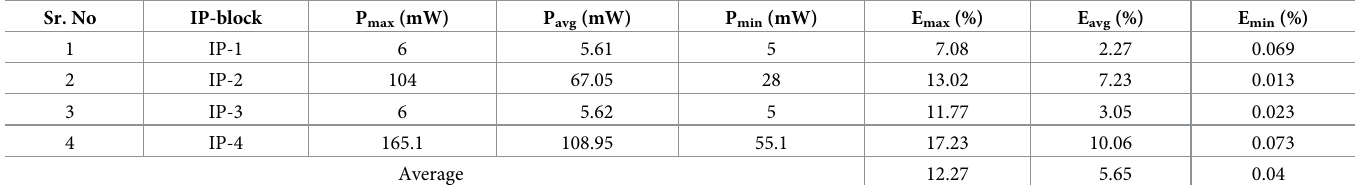
Table 4. Power estimates and accuracy for test-system III.